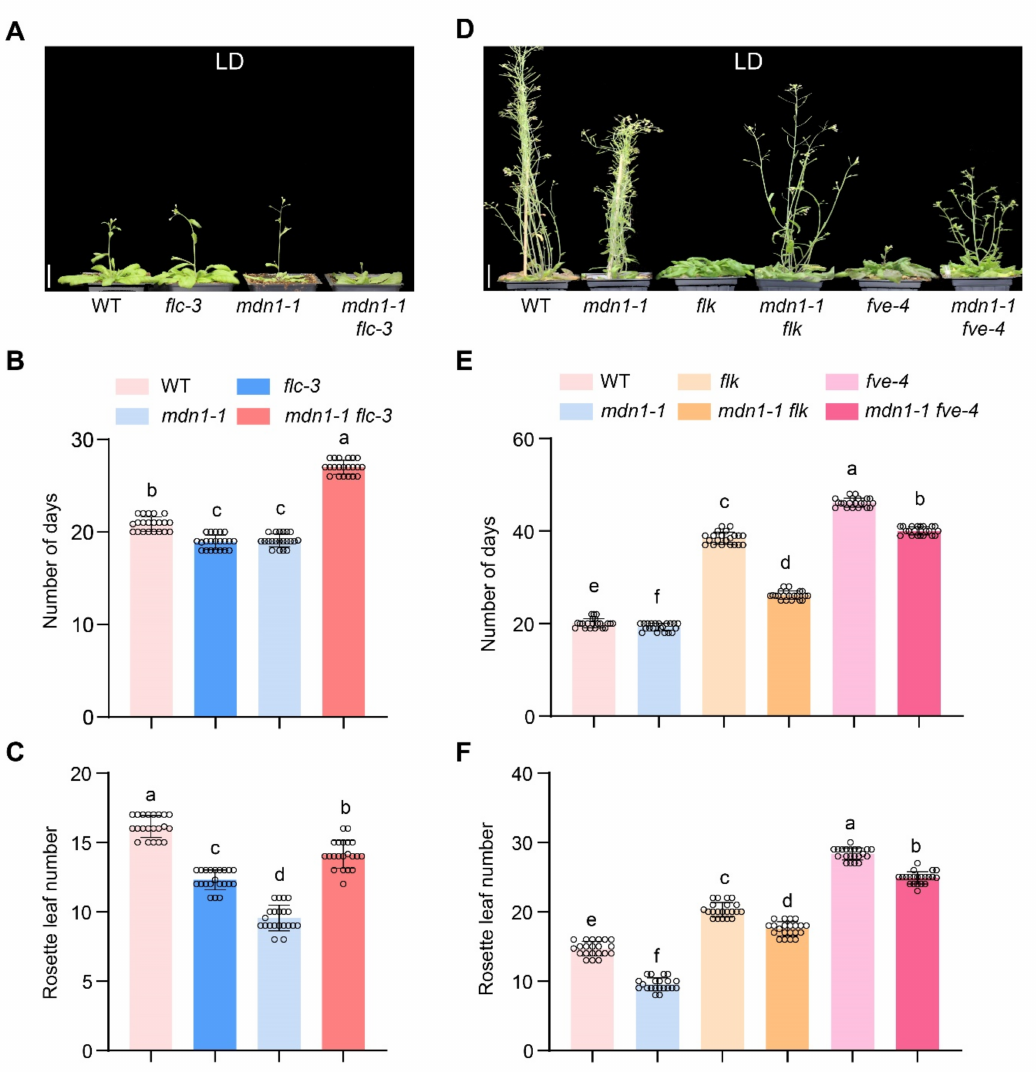
Figure 3. The flowering time of FLC -related mutants in mdn1-1 background. ( A ) flc-3 , mdn1-1 and mdn1-1 flc-3 plants grown in LD. ( B , C ) The number of days and rosette leaf number at the flowering in LD. ( D ) mdn1-1 , flk , mdn1-1 flk , fve-4, and mdn1-1 fve-4 plants grown in LD. ( E , F ) The number of days and rosette leaf number at the flowering in SD. Twenty plants per line were scored. One-way ANOVA was employed, and the lowercase letters denote distinct groups ( p < 0.01). Scale bars, 2